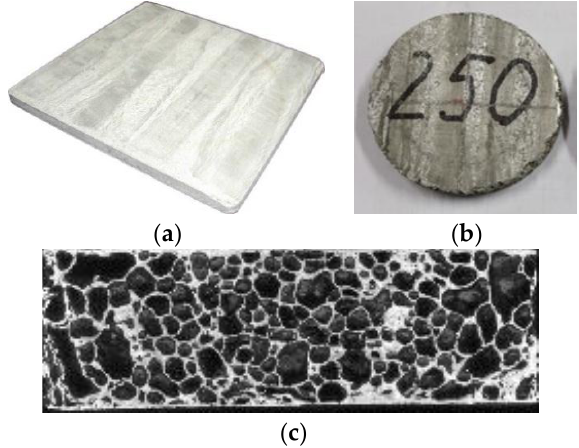
Figure 1. ( a ) Prepared aluminium foam plate, ( b ) disc sample for the impulse excitation technique (IET)test, and ( c ) typical cell structure of foam, density 0.50 g·cm −3 .